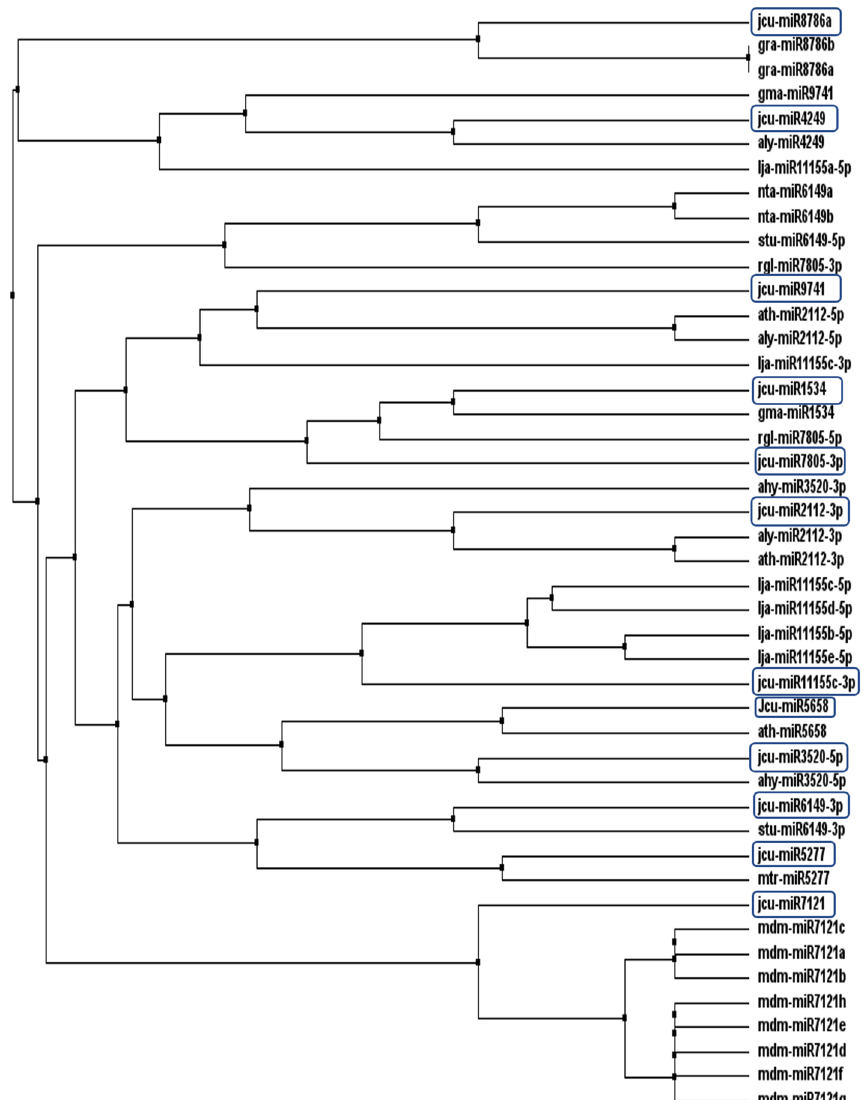
Fig. 6 Phylogenetic analysis of 12 newly identified miRNAs of Jatropha